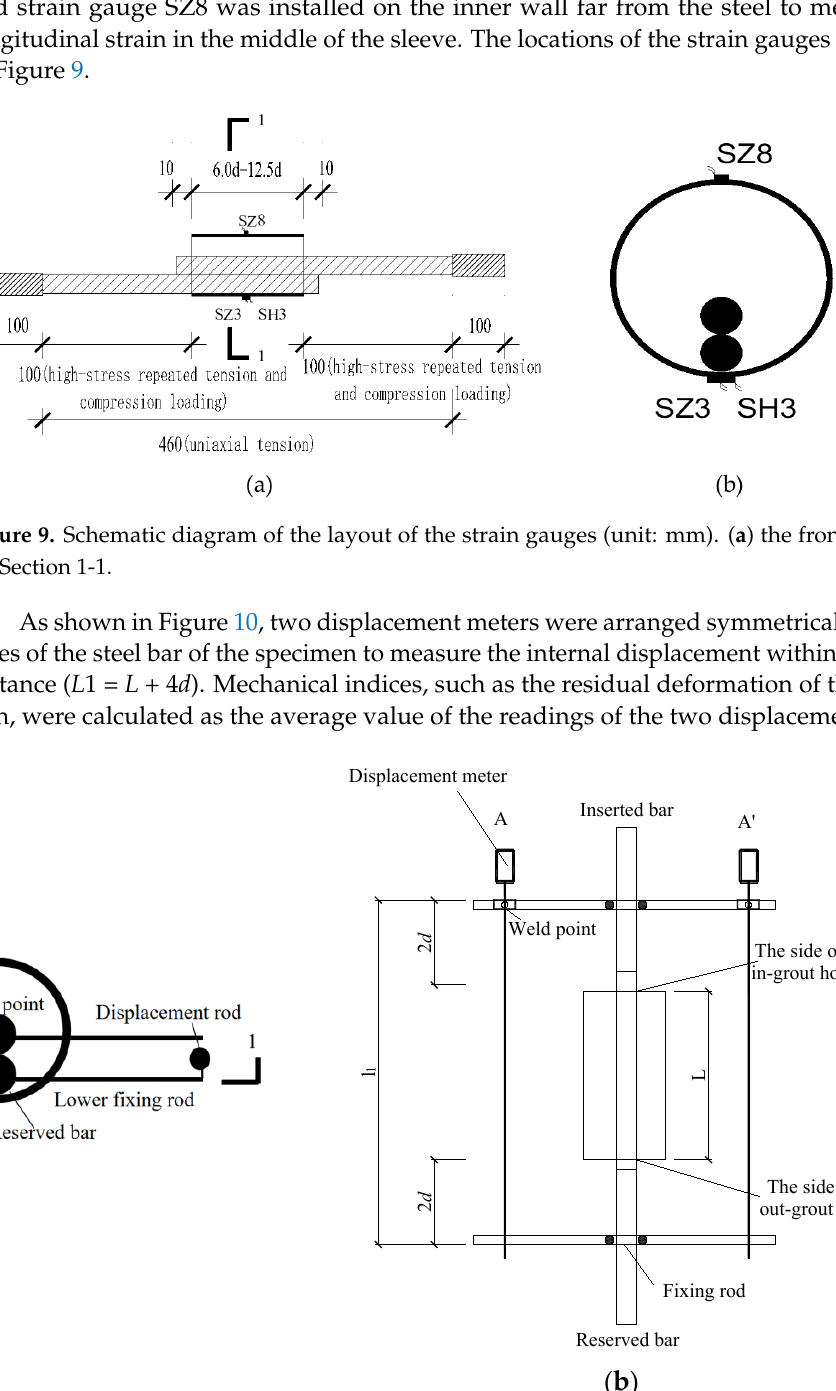
Figure 10. Layout of displacement meter: ( a ) plan and ( b ) Section 1–1.